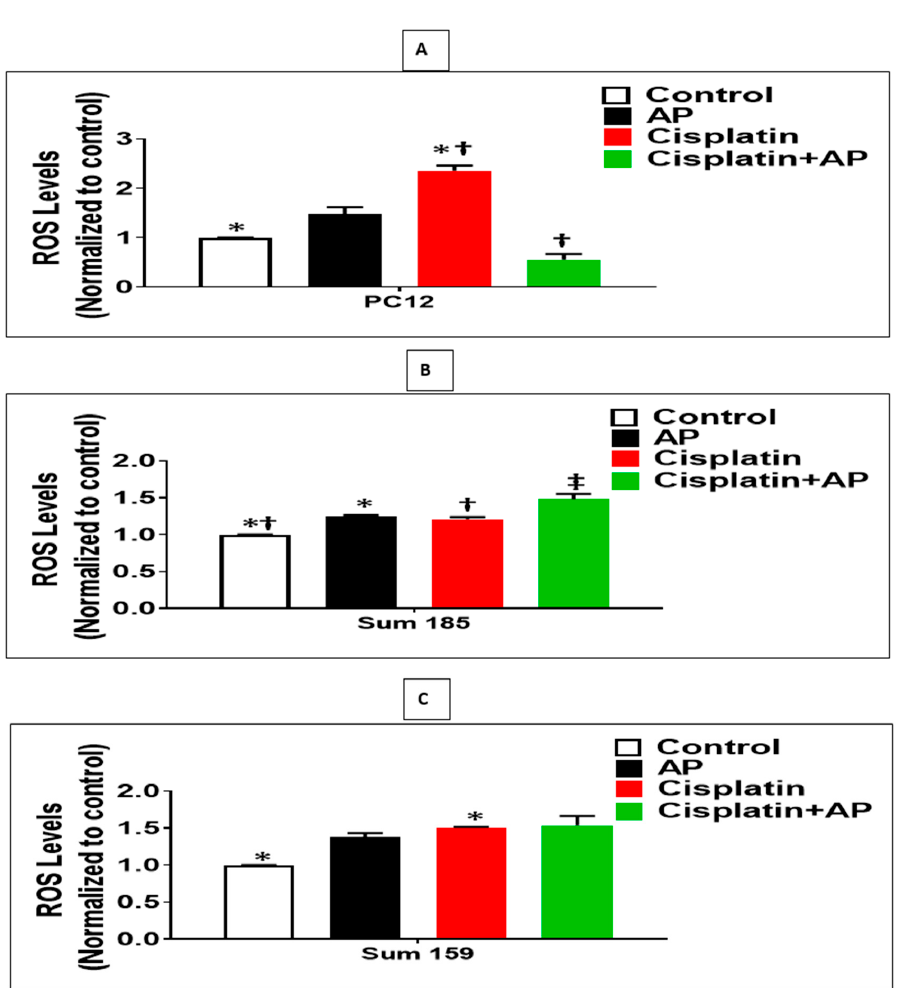
Figure 3. NK1R Antagonism decreased cisplatin-induced ROS in rat neuronal PC12 cells while causing increased cisplatin- induced ROS levels in TNBC cells. Effect of NK1R antagonism on ROS Production induced by cisplatin in PC12 cells and TNBC cells. Levels of ROS as determined by the DCFDA assay, in untreated (media control) or treated with aprepitant or cisplatin alone or cisplatin + aprepitant, in PC12 ( A ), Sum 185 ( B , C ), Sum 159 cells (* , † , ‡ , p ≤ 0.05, ANOVA, n = 2). Only statistical comparisons between control vs. aprepitant (AP) or Cis and Cis vs. Cis + AP are shown.